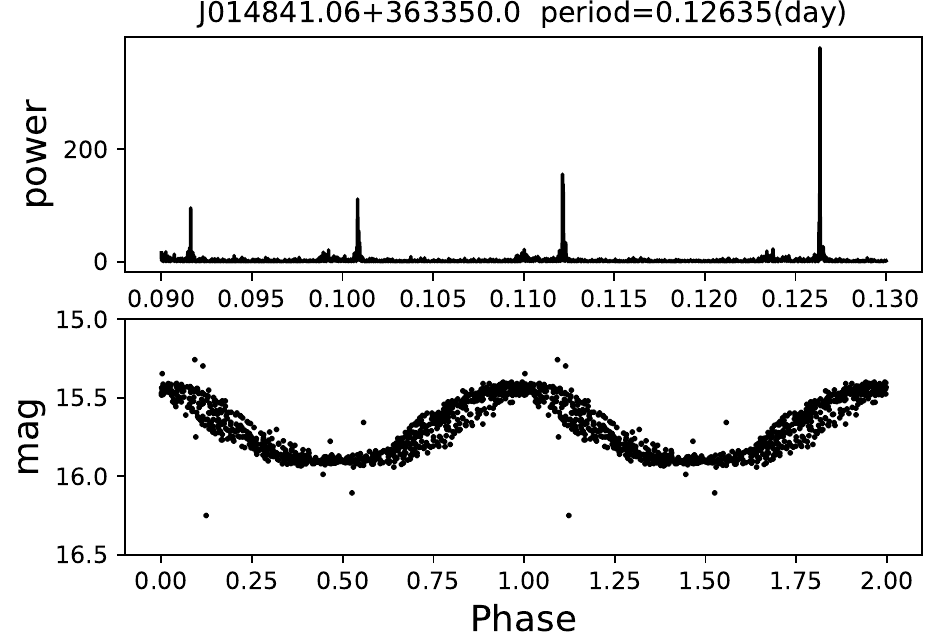
Figure 11. Power spectrum light curve and phase folding diagram of J014841.06 + 363350.0.